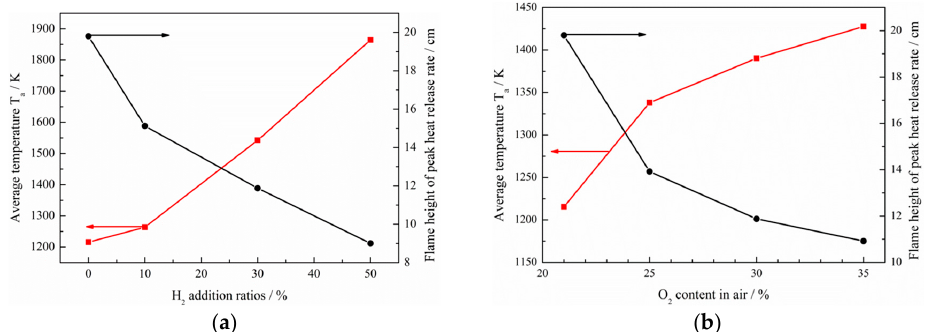
Figure 8. Effects of H 2 addition ratio ( a ) and O 2 enrichment levels ( b ) in BG-2/air flame on the peak heat release height and average temperature T a .